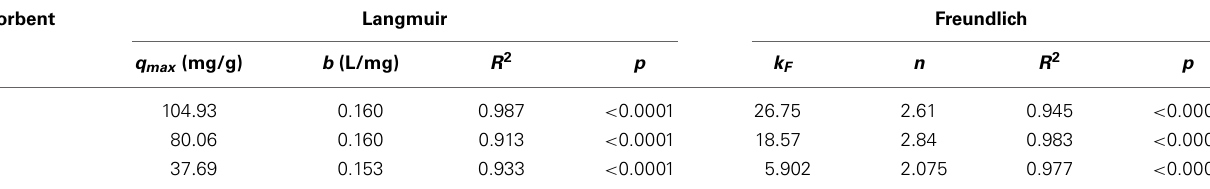
Table 1 | Langmuir and Freundlich Isotherm Constants for the adsorption of BY57 onto lignocellulosic adsorbents. Adsorbent Langmuir Freundlich